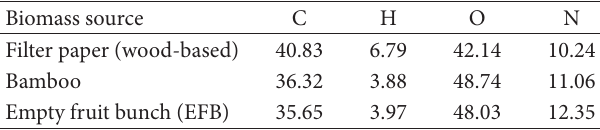
F 3: XRD diffractogram of carbon (bamboo, FP, and EFB) synthesized by dehydration process.